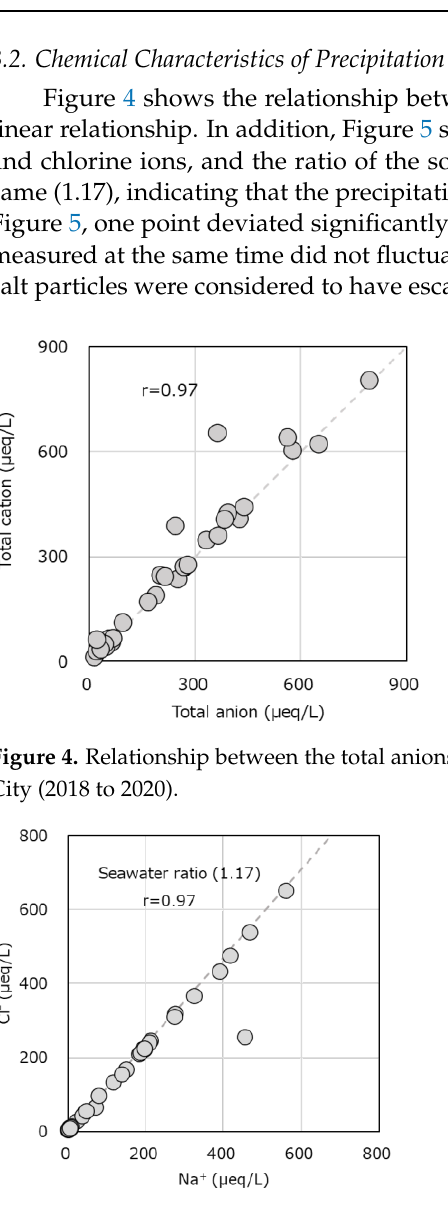
Figure 5. Relationship between the Na + and Cl − concentrations in the monthly precipitation at Hirosaki City (2018 to 2020).